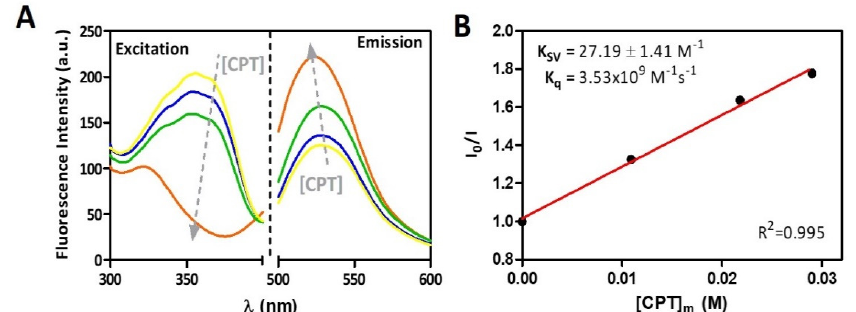
Figure 4. ( A ) Fluorescence excitation spectra of CPT ([CPT] T of 0 to 4 × 10 − 5 M) added to cancer membrane models (3.0 × 10 − 2 M) labeled with NBD-PE probe and correspondent emission spectra of the probe ( λ exc = 360 nm). ( B ) Stern-volmer plot of fluorescence quenching as a function of membrane concentrations of CPT calculated according to Equation